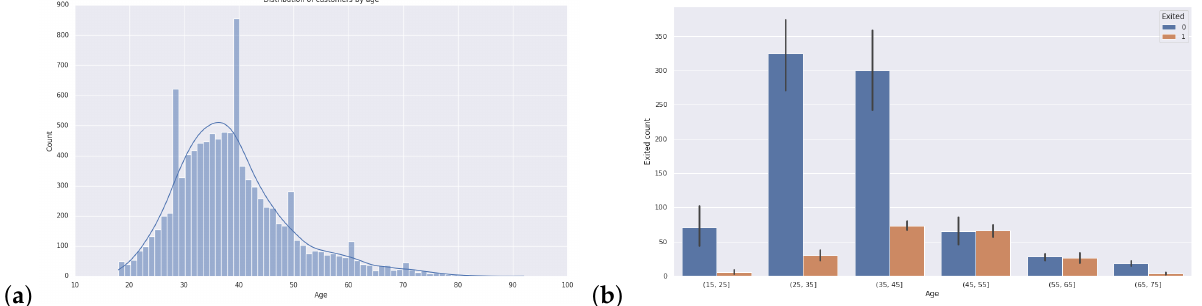
Figure 2. Visualizing age variable ( a ) distribution and ( b ) group by exited